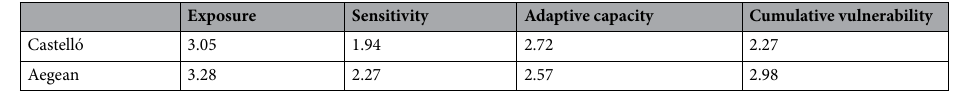
Table 3. Vulnerability from the fishing areas: Castelló and Aegean. The scores for exposure, sensitivity and adaptive capacity dimensions are calculated using Eq. (1) 58,67 , and cumulative vulnerability score is calculated with Eq. (2) 58 .